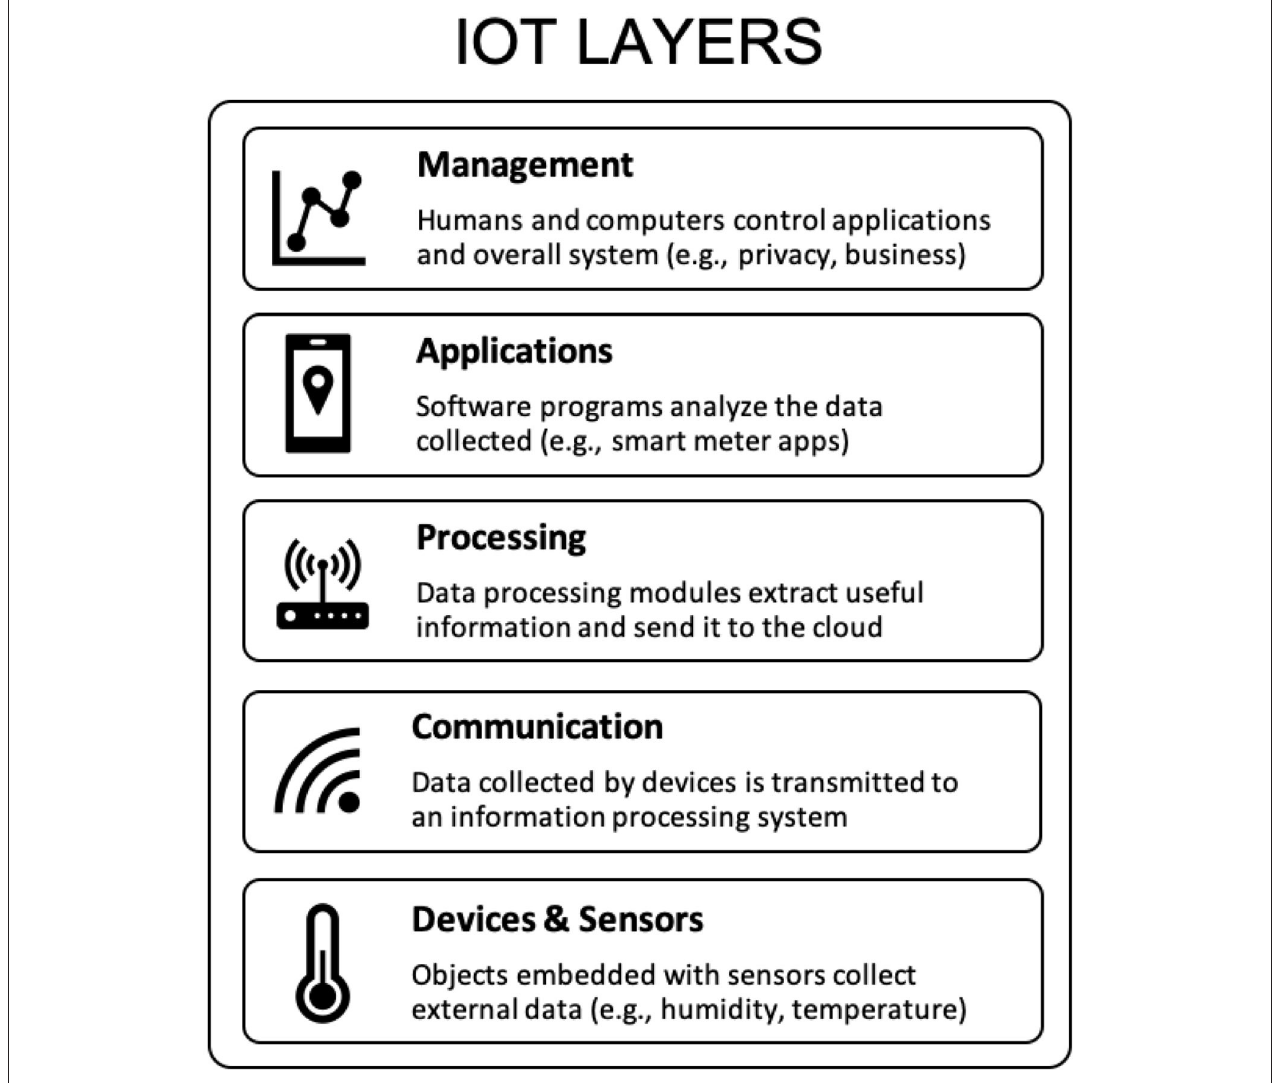
FIGURE 1 | The five main layers of IoT comprise devices, communications protocols, processing systems, applications, and management. Source: